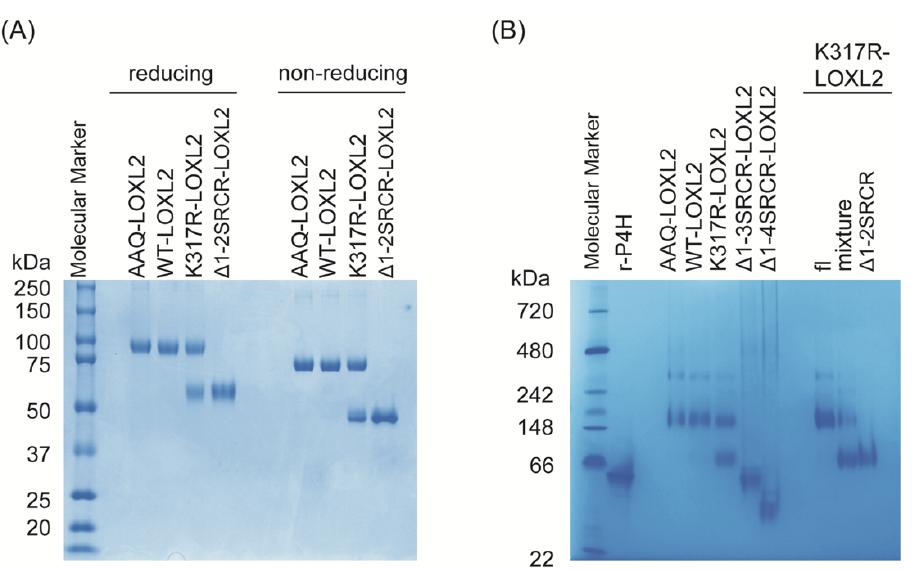
Figure 3. Polyacrylamide gel electrophoresis (PAGE) of LOXL2s. ( A ) SDS-PAGE under denaturing conditions in the presence and absence of reductant ( β -mercaptoethanol). ( B ) Native-PAGE. AAQ: R315A/R316A/K317Q mutant form of LOXL2; WT: wild type; K317R-LOXL2 was isolated as a mix- ture of fl-LOXL2 and Δ 1-2SRCR-LOXL2; Δ 1-2SRCR-LOXL2 was isolated from the mixture by FPLC; r-P4H: recombinant Bacillus anthracis prolyl-4-hydroxylase as a molecular standard (homodimer, 49.2 kDa) [22].